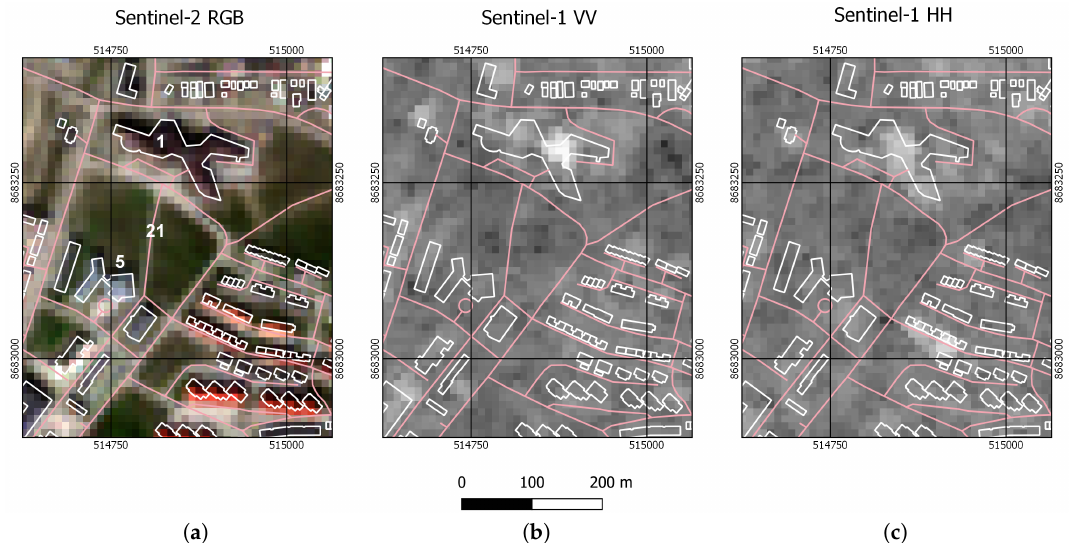
Figure 1. Examples for Sentinel-1 and Sentinel-2 data for Longyearbyen, Svalbard, and Norway: ( a ) Sentinel-2 red–green–blue (band 4-3-2) composite, for dates see Table 2. ( b ) Sentinel-1 VV polarization backscatter in dB ( σ 0 , linear stretch − 30 to 10 dB), descending orbit (looking direction from ESE), 05.01.2019. ( c ) Sentinel-1 HH polarization backscatter in dB ( σ 0 , linear stretch − 30 to 10 dB), ascending orbit (looking direction from WSW), 07.01.2019. Building (white lines) and road (pink lines) vectors from OpenStreetMap. Numbers correspond to object IDs in Lu et al. [54]. See also Figure 2. Projection WGS 84/UTM zone